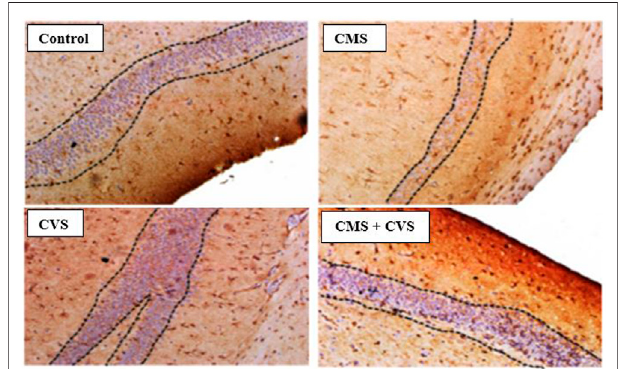
FIGURE5| ImmunohistochemicalstainingforBDNFinrathippocampus section. Shown are representative photomicrographs of different groups of rats. BDNF staining is prominently visible in the sections as dotted lines.